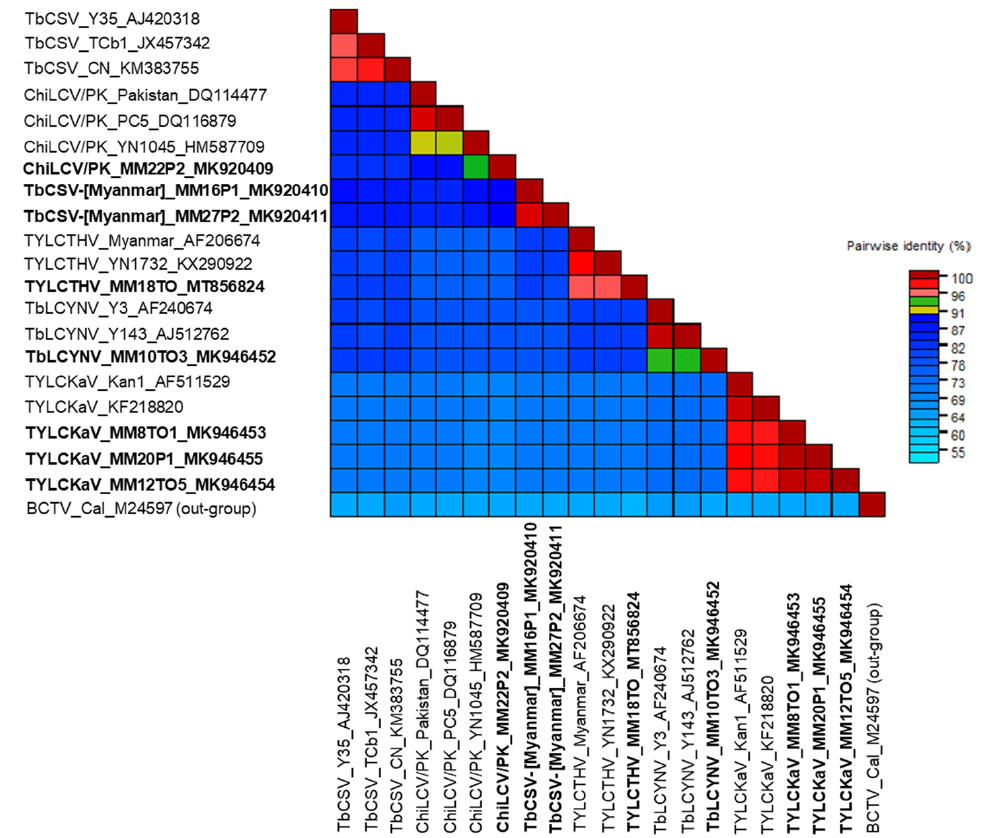
Figure 3. Color-coded pairwise identity matrix generated by Sequence Demarcation Tool from 20 begomovirus genomes. BCTV (accession no. M24597) was used as an outgroup for the analysis. Each colored cell represents a percentage identity score between two sequences (red = 94% {strains}, yellow-green = 91% {same species}, blue < 91% {different species}). Viruses isolated in this study are shown in bold font. Table 3. Nucleotide and amino acid sequence identities (%) between Myanmar isolates TbCSV- [Myanmar]-MM16P1 and other TbCSV and ChiLCV/PK